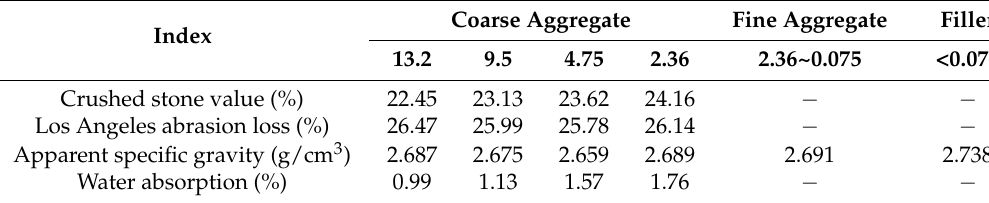
Table 2. Physical properties of aggregates and filler.